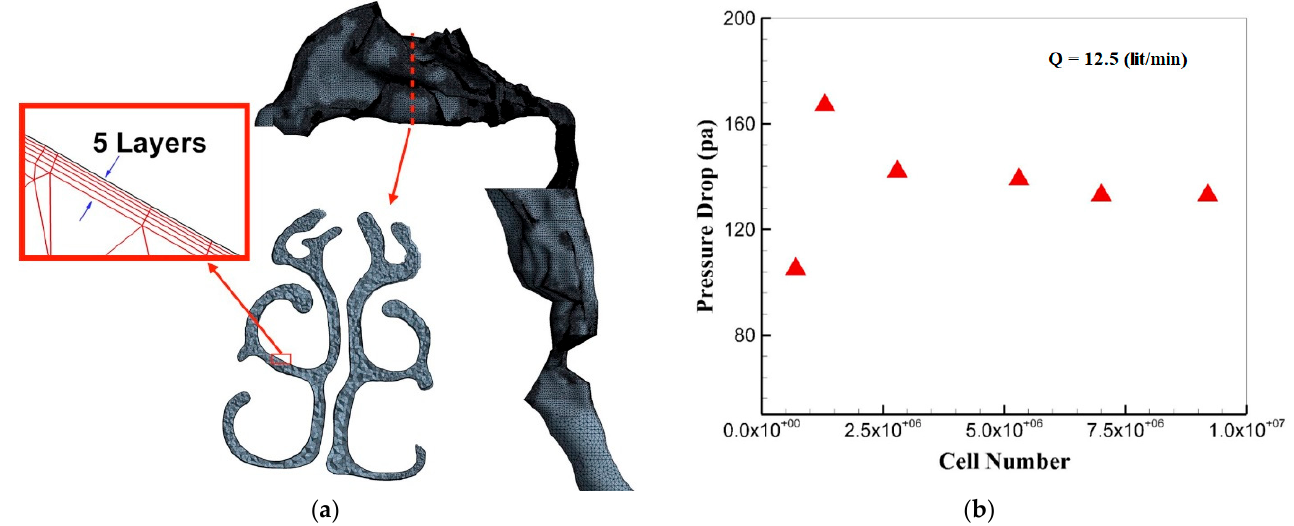
Figure 14. Grid independency analysis; ( a ) unstructured mesh in the entire upper airway, with a close-up view of a specific cross-section and the five-layer prism mesh on the wall; ( b ) effects of the total cell number on the pressure drop at a flow rate of 12.5 L/min.